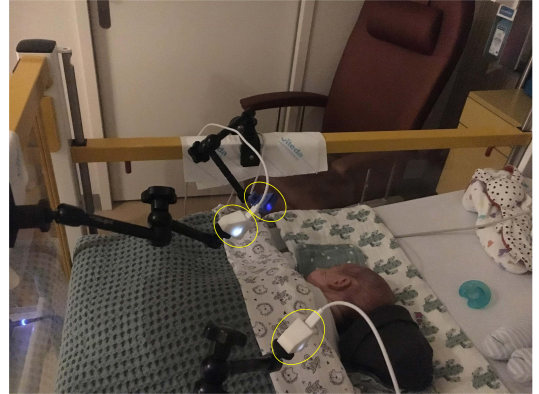
Figure 1. Experimental setup. Reprinted with permission from [32] © The Optical